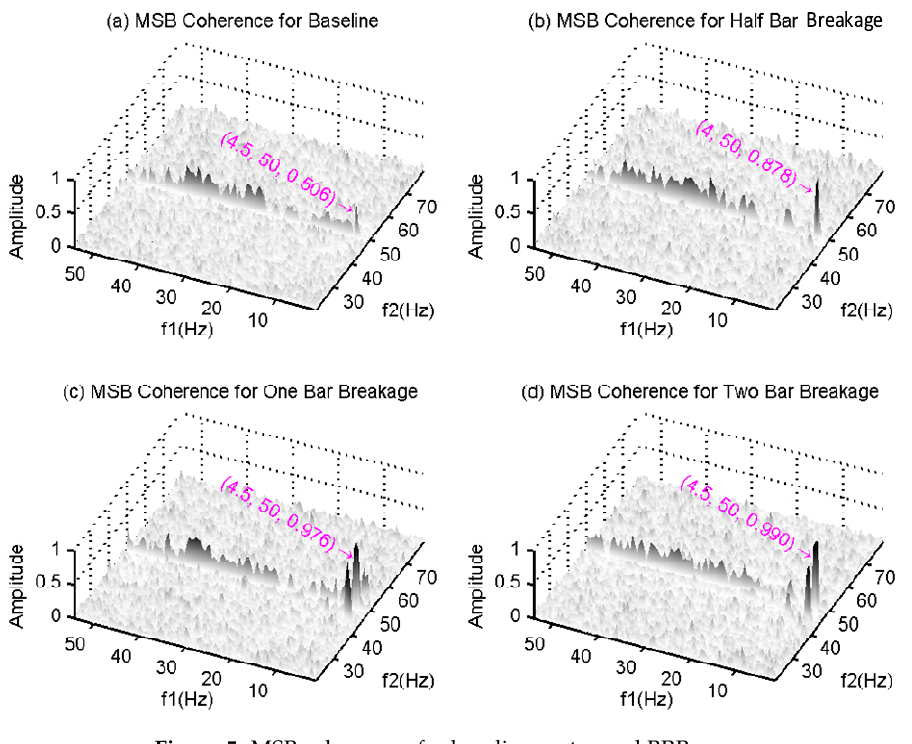
Figure 5. MSB coherences for baseline motor and BRB cases.